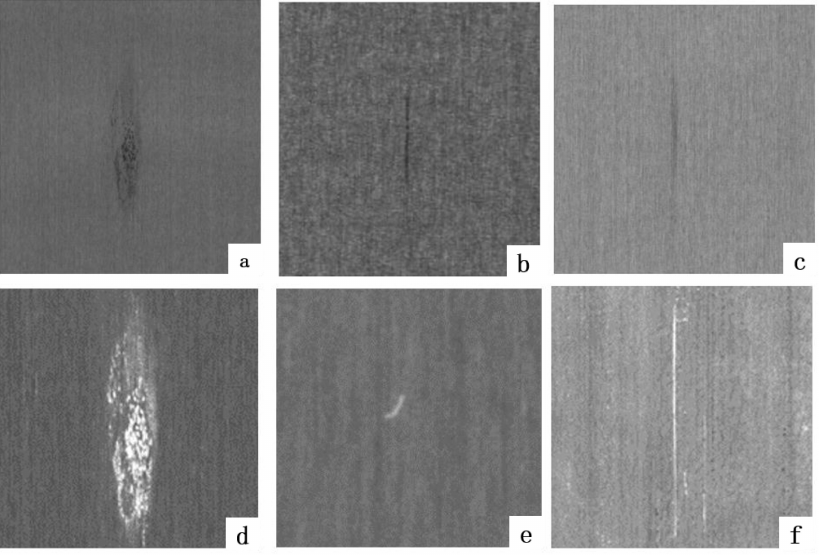
Figure 8. Sample diagram of defects in aluminum strips: ( a,d ) blot; ( b,e ) lacerate; ( c,f )